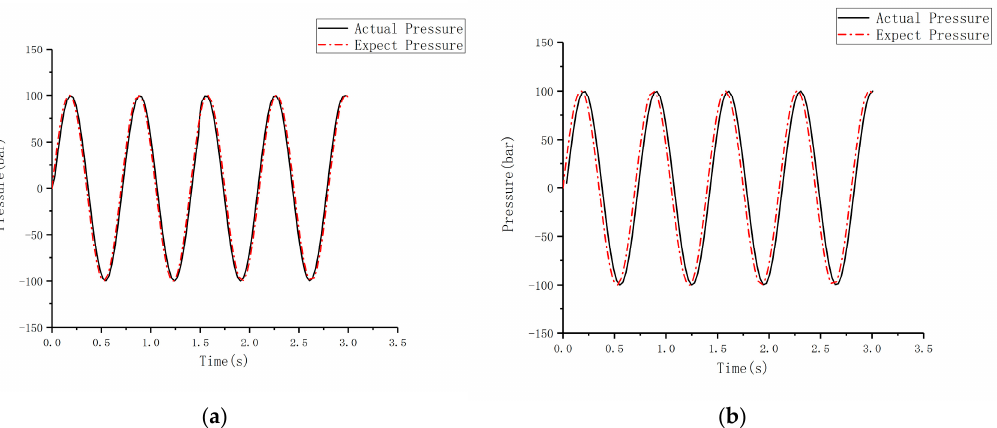
Figure 16. Sinusoidal signal pressure simulation curve. ( a ) Pressure curve of DTC system controlled by sliding-mode system under sinusoidal signal. ( b ) Pressure curve of variable-speed system under sinusoidal signal.